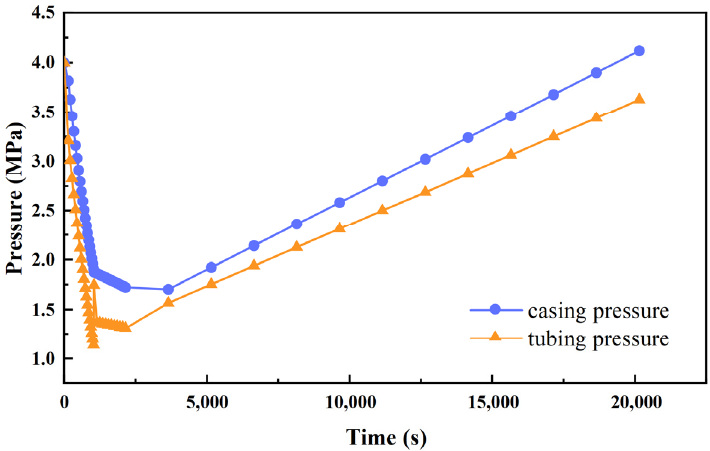
Figure 11. Variations in tubing pressure and casing pressure.